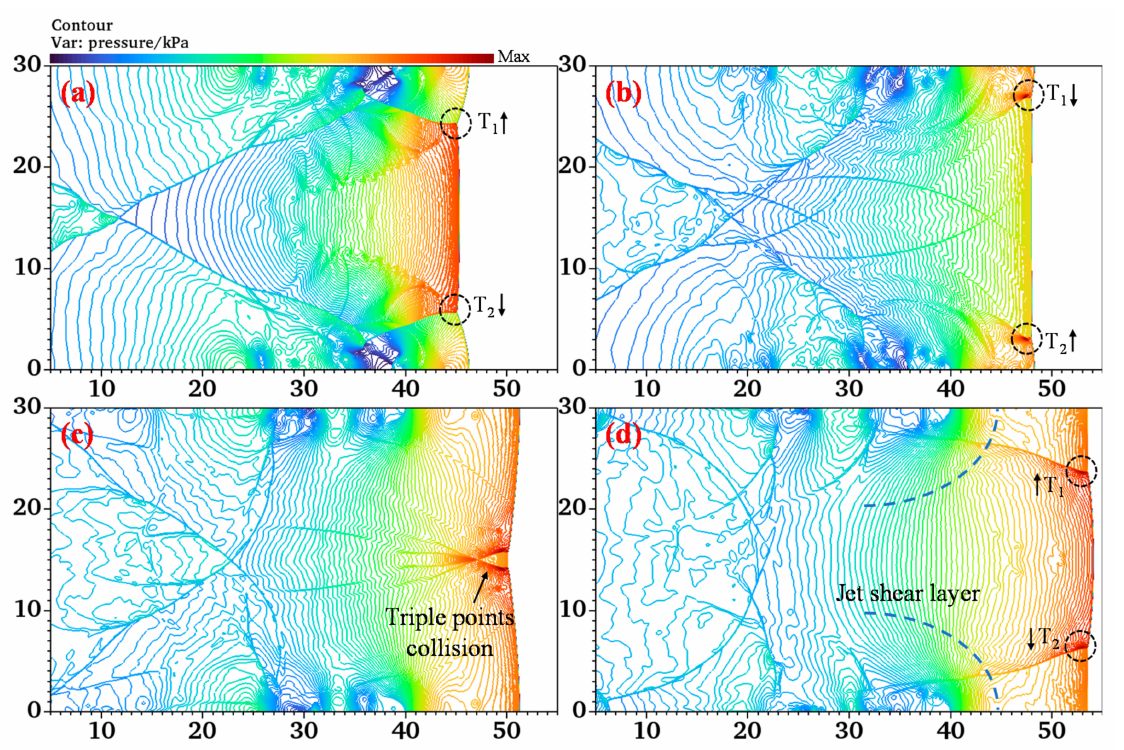
Figure 9. Pressure isolines showing propagation of triple points in detonation initiation of a symmetric-jet: ( a ) t = 180 µ s; ( b ) t = 195 µ s; ( c ) t = 207.5 µ s; ( d ) t = 220 µ